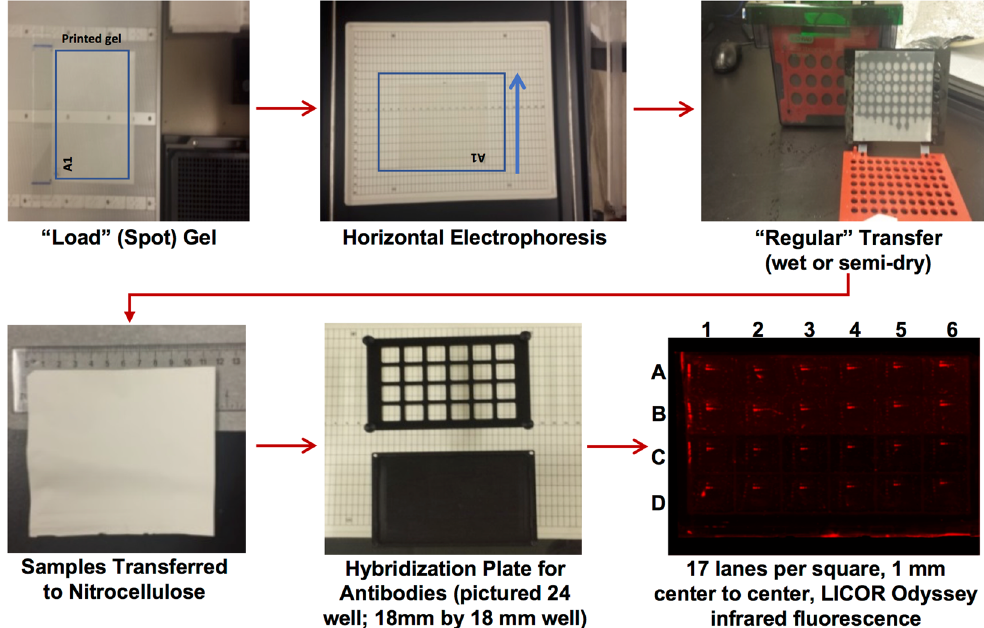
Figure 1. Work Flow for the Microwestern. The major steps involved in the Microwestern protocol from spotting the samples onto the gel to the final image showing sample signals in a 24 well setup. Details are presented in Methods and the referenced SOPs